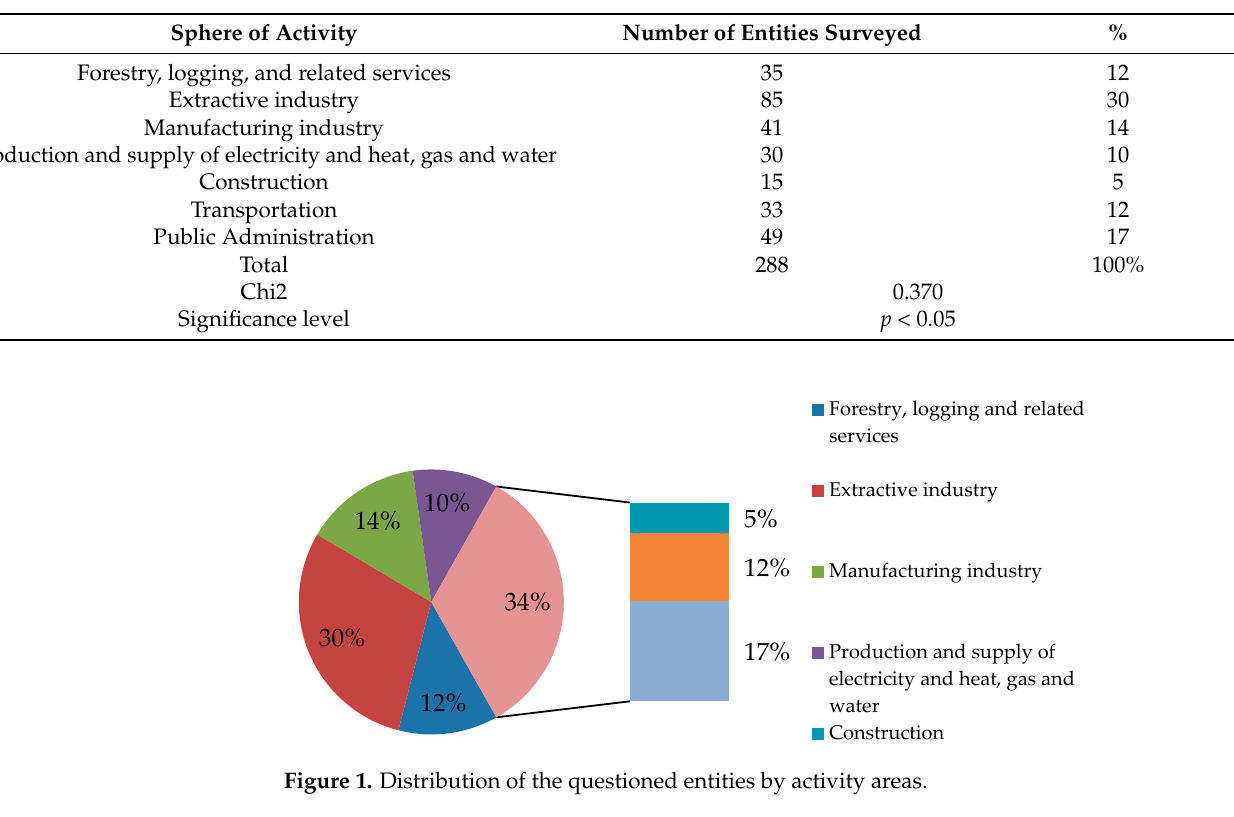
Table 3. Entities surveyed.